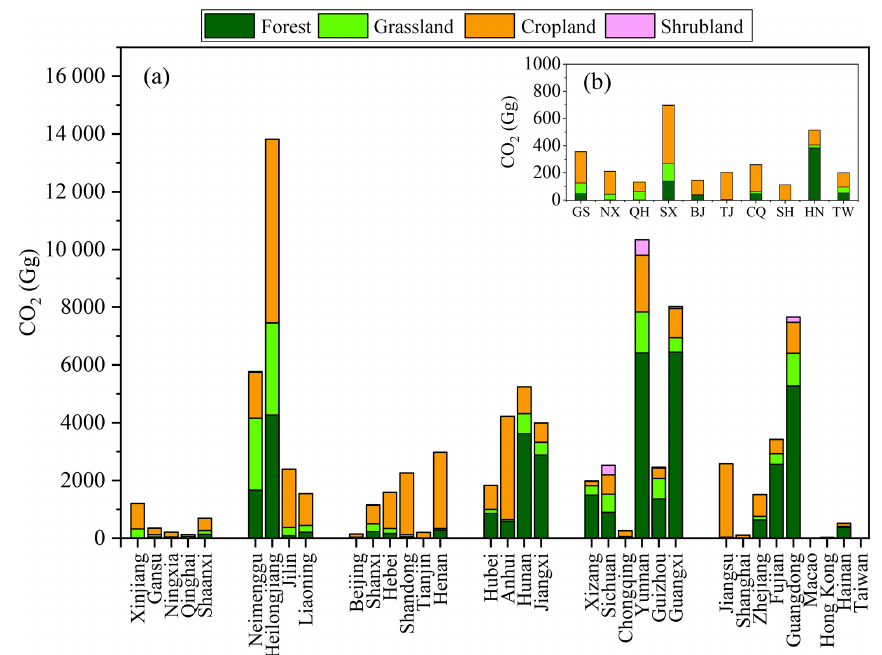
Figure 1. (a) Source-specific CO 2 emission in each province. Each group of bars represent a region (from left to right): northwest (Xinjiang– Shaanxi), northeast (Neimenggu–Liaoning), north (Beijing–Henan), central (Hubei–Jiangxi), southwest (Xizang–Guangxi), and southeast (Jiangsu–Taiwan). Ten provinces and municipalities with emissions lower than 1000Ggyr − 1 were shown in detail in (b) : Gansu (GS), Ningxia (NX), Qinghai (QH), Shaanxi (SX), Beijing (BJ), Tianjin (TJ), Chongqing (CQ), Shanghai (SH), Hainan (HN), and Taiwan (TW). Macao and Hong Kong have minimal emissions: 0.5Gg in Macao, consisting of 0.4Gg from forest fires and 0.1Gg from grassland fires; and 24.7Gg in Hong Kong, consisting of 20.6Gg (83%) from forest fires, 2.7Gg (11%) from grassland fires, 0.7Gg from shrubland, and 0.7Gg from cropland